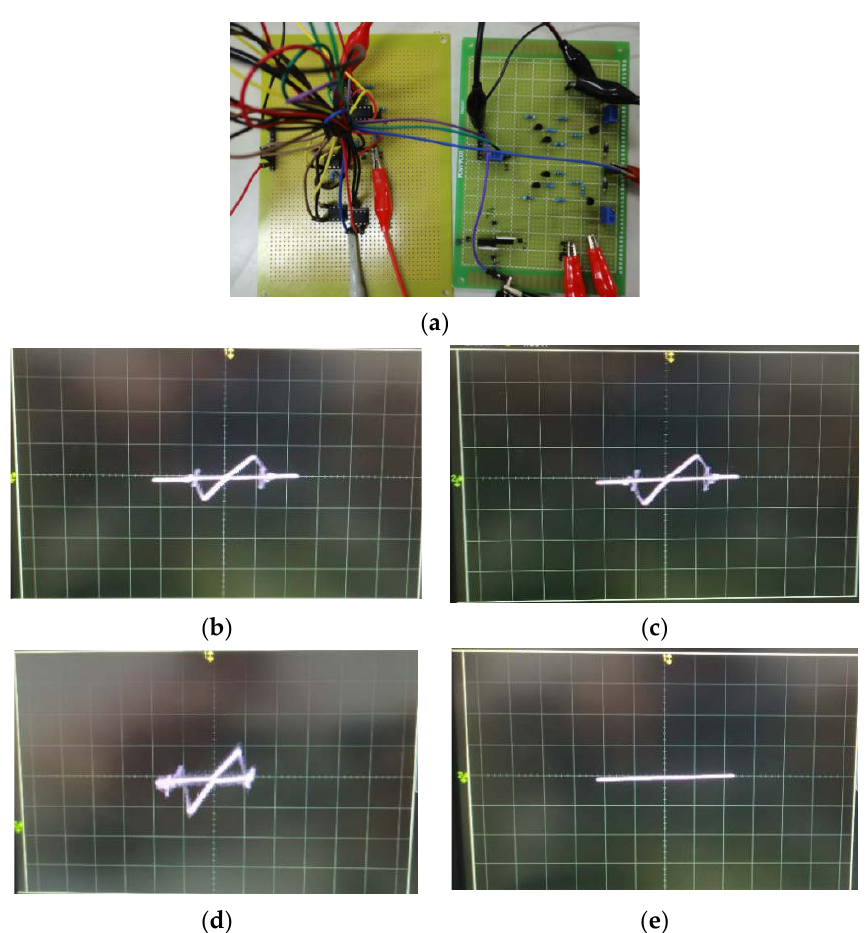
Figure 14. Hardware circuit and experimental results: ( a ) the circuit of the threshold-controllable memristor emulator, ( b ) V ctr = 2 V, f = 72 kHz, ( c ) V ctr = 6 V, f = 72 kHz, ( d ) V ctr = 6 V, f = 250 kHz, ( e ) V ctr = 6 V, f = 345 kHz.